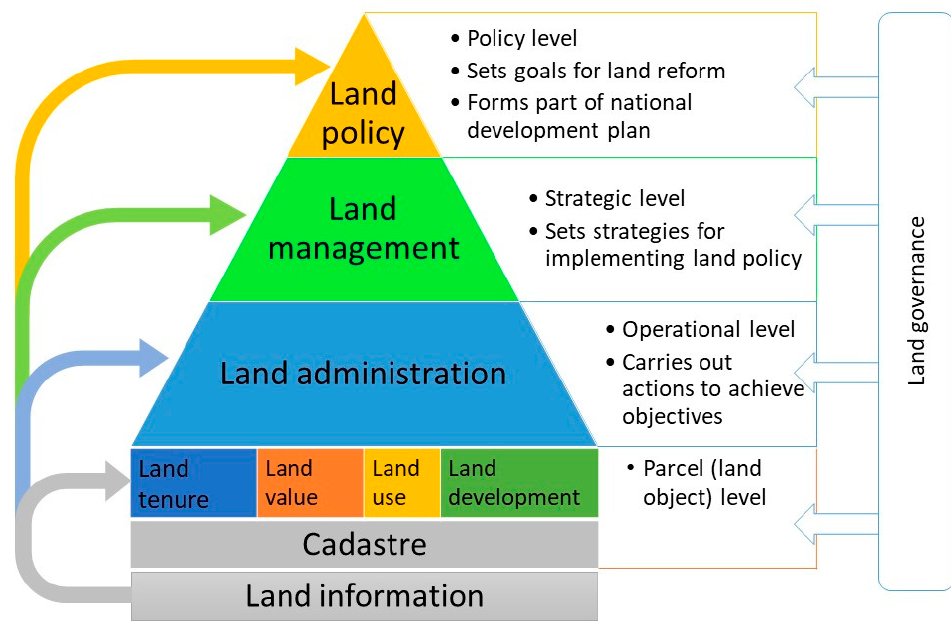
Figure 3. Hierarchy and functions of elements of Land Administration Systems [62].